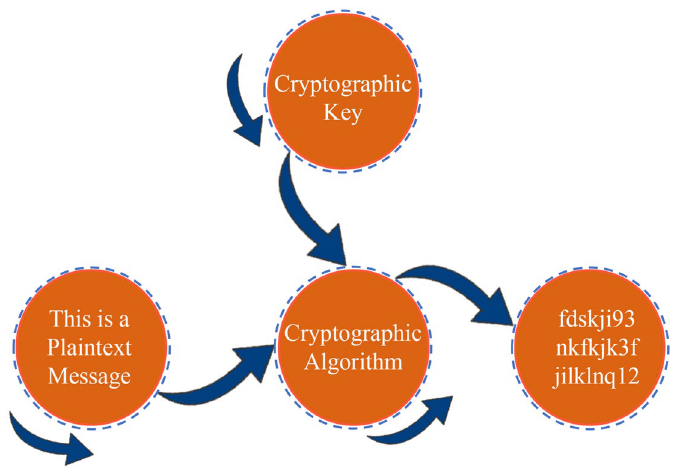
Figure 1. Encryption and decryption process using a